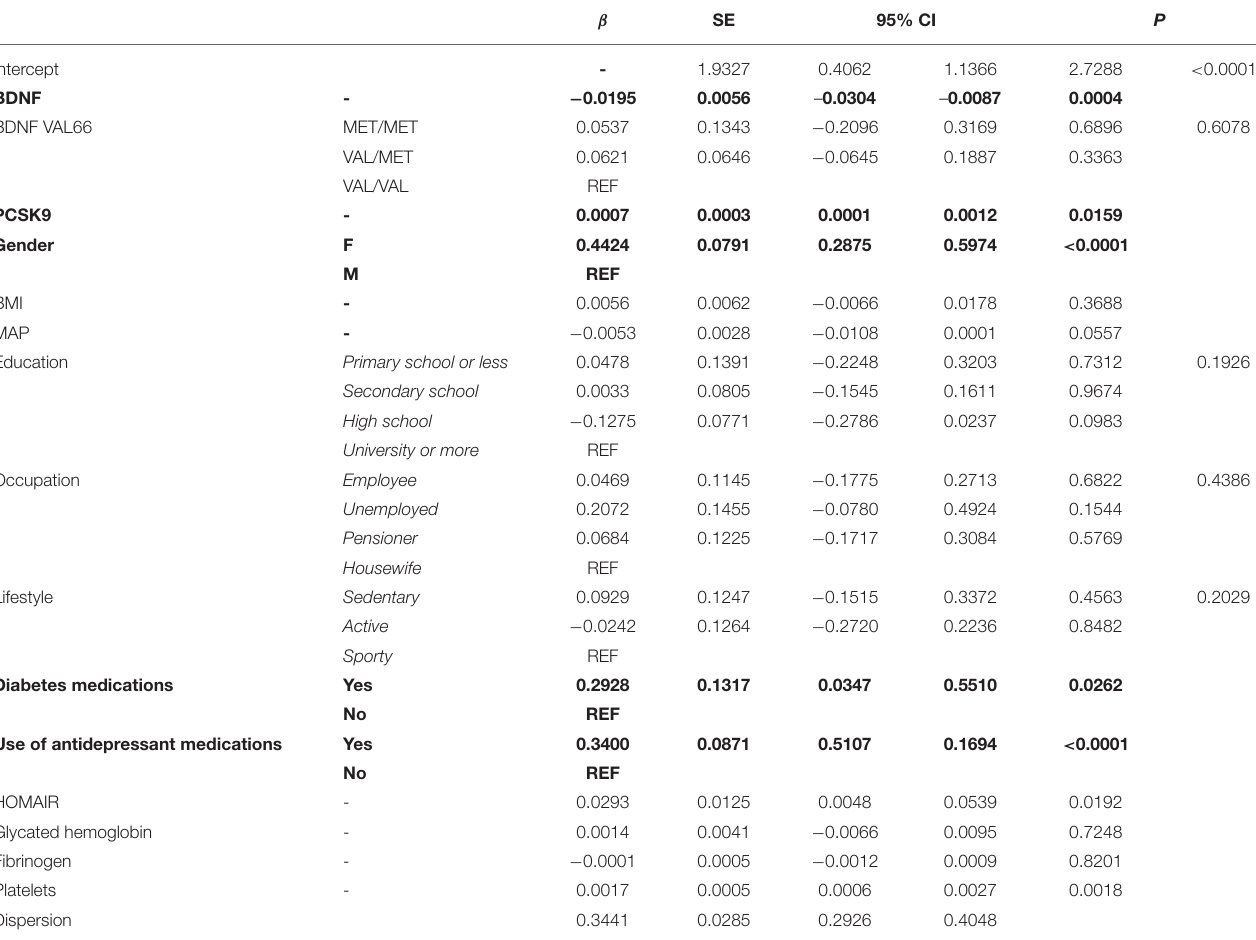
TABLE 2 | Negative binomial regression model evaluating the association between BDI-II score and BDNF adjusted for participant’s characteristics.